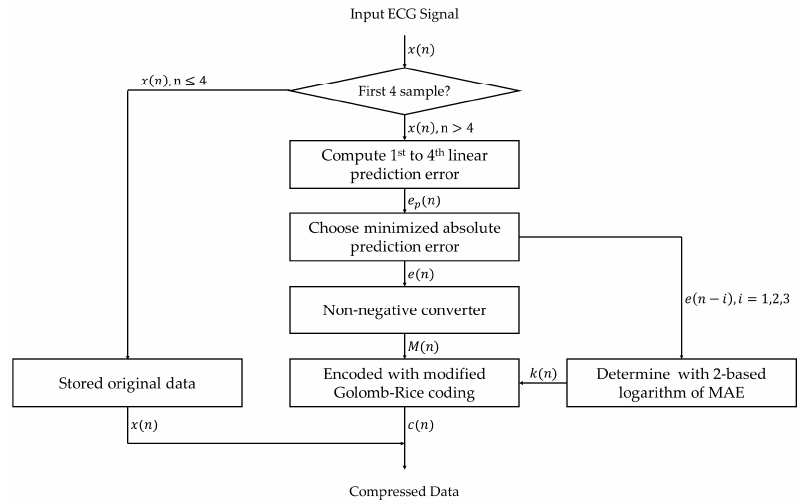
Figure 5. Flowchart of the proposed ECG lossless compression